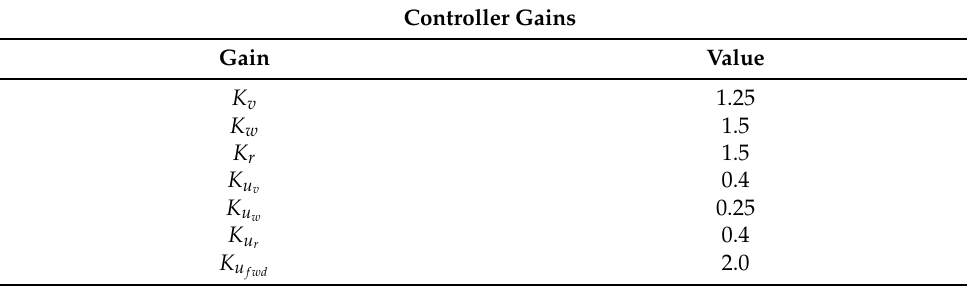
Table A2. Controller gain values used to collect the presented